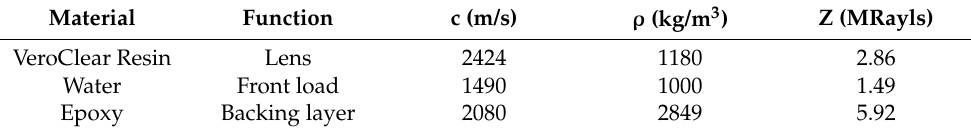
Table 2. Other materials used in the PZFlex